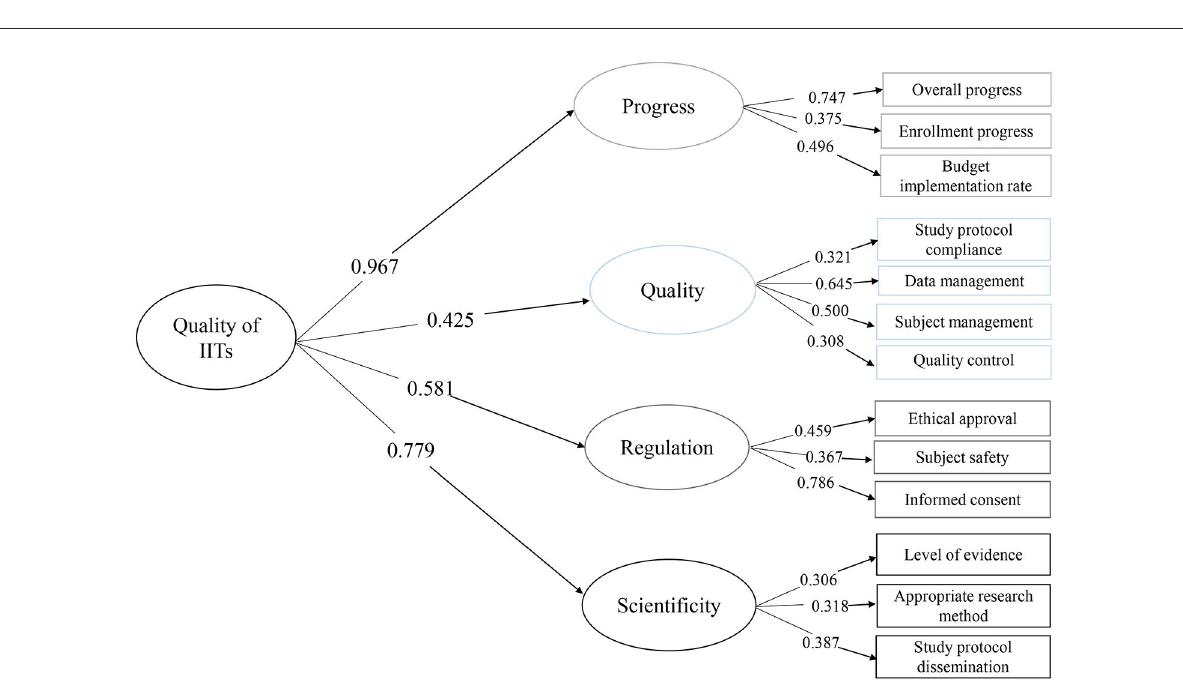
FIGURE3 Confirmatory factor analysis (CFA) of key indicators to the quality of